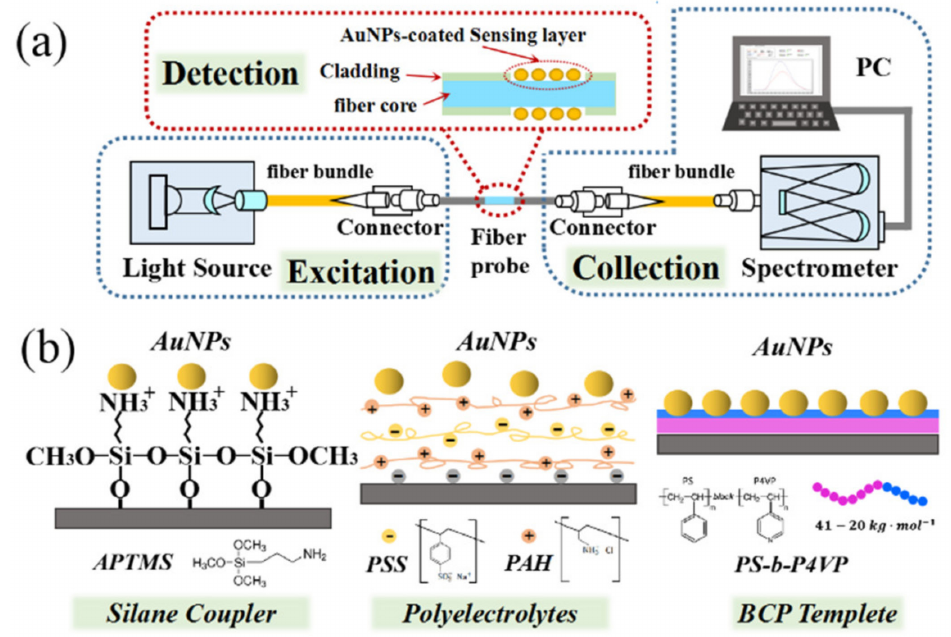
Figure 1. Schematic diagram of ( a ) gold nanoparticle (AuNP)-based fiber-optic localized surface plasmon resonance (LSPR) sensor; ( b ) AuNP self-assembly principle bases on silane coupler, poly- electrolytes and block copolymer (BCP)-templating technique,